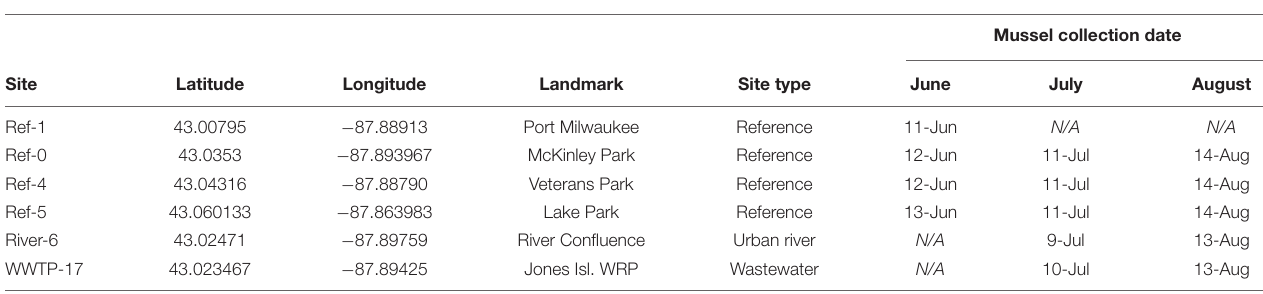
FIGURE 1 | The study sites are locations in (A) the United States of America, (B) State of Wisconsin, and (C) city of Milwaukee. Sites 0–5 are Great Lakes Mussel Watch reference locations. Site 6 is at the confluence of the Milwaukee and Kinnickinnic Rivers. Site 17 is at the outfall of the Jones Island Water Reclamation (i.e., wastewater treatment) Plant. The square at the confluence of the Milwaukee and Kinnickinnic Rivers is the sampling site for fish in McNeish et al. (2018). TABLE 1 | Mussel collection locations and 2018 sampling